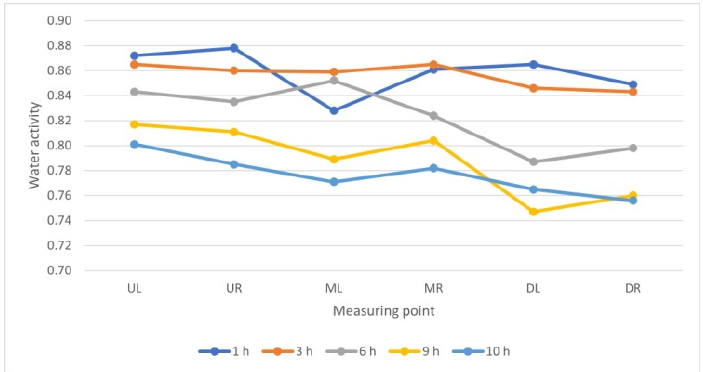
Figure 18. Comparison of changes in water activity (Wa) of beef samples in chamber 4 depending on